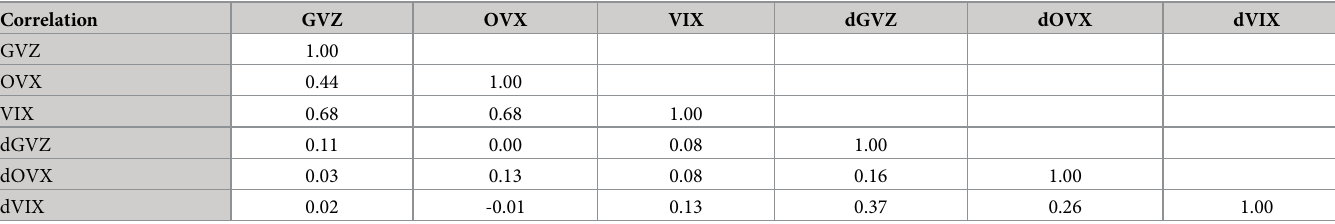
Table 2. Correlations between implied volatilities, full sample